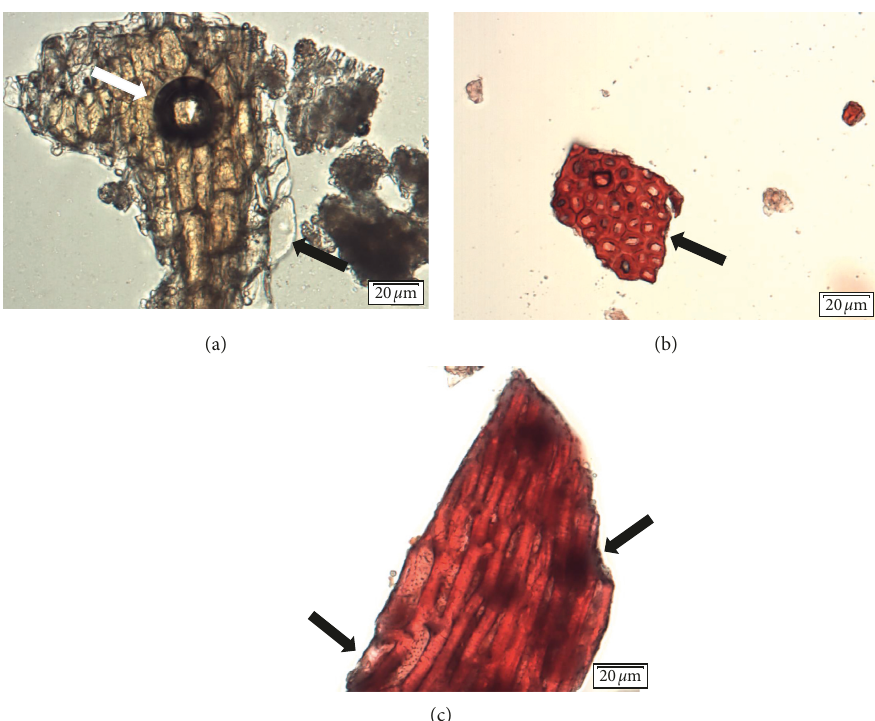
Figure 1: Seeds of cloudberry (a), black currant (b), and bilberry (c) dried and milled for 30s. White arrow indicates oil droplet released after milling. Black arrows indicate disrupted cells.